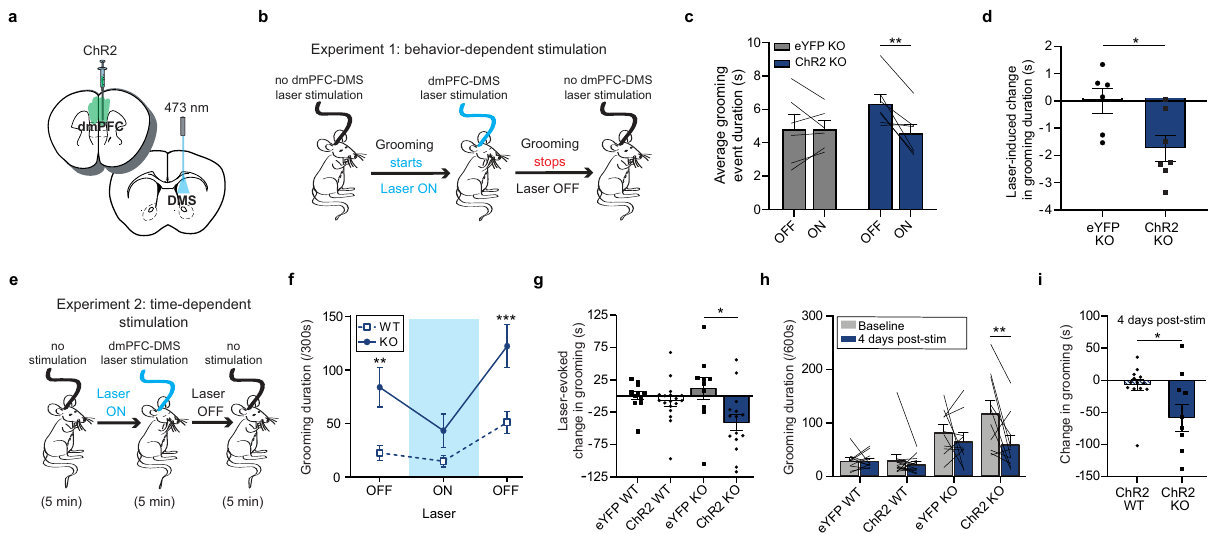
Fig. 6 Optogenetic stimulation of dmPFC-DMS projections reduces compulsive grooming in SAPAP3 KO mice. Bar and line graphs show data means + / − SEM. Source data are provided as a Source data fi le. * P <0.05, ** P <0.01, *** P <0.001. Black lines on bar graph ’ s represent individual animals. Lines start and stop at individual animal ’ s average for that graph ’ s conditions. a Cartoon of viral injection and implant. b Graphical representation of behavior-dependent stimulation experiment (ChR2-KO mice = 7, eYFP-KO mice = 6). c Duration of grooming epochs during behavior-dependent stimulation (two-way RM ANOVA: interaction P = 0.0252, laser P = 0.0241, virus P >0.05, subject P = 0.0043; Sidak ’ s multiple comparisons: ChR2-KO on vs off P = 0.0056). d Laser-evoked change in average duration of grooming epochs (unpaired two-tailed t -test P = 0.0252). e Graphical representation of time-dependent stimulation experiment (ChR2-KO = 15,